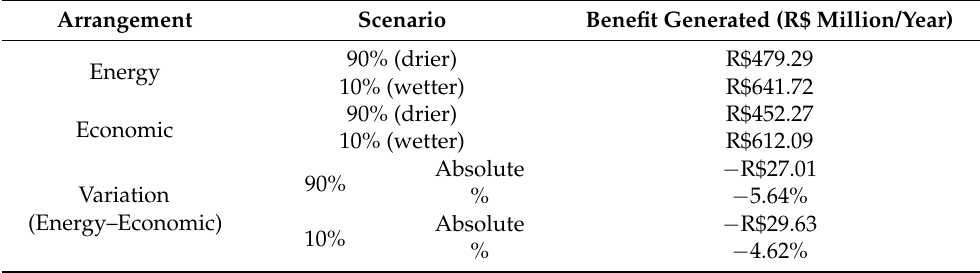
Table 2. Economic benefit generated in both scenarios and allocation